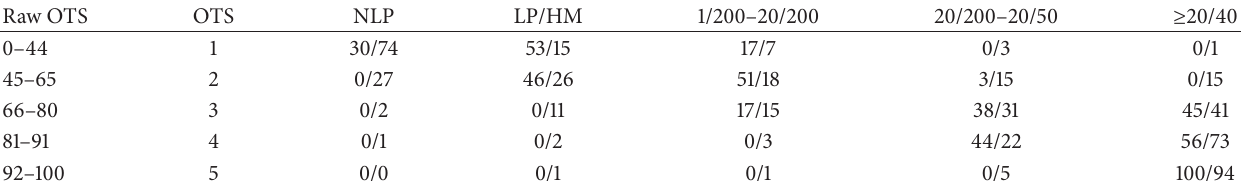
Table 5: Percentage with final VA and OTS categorical distribution in this study and the OTS